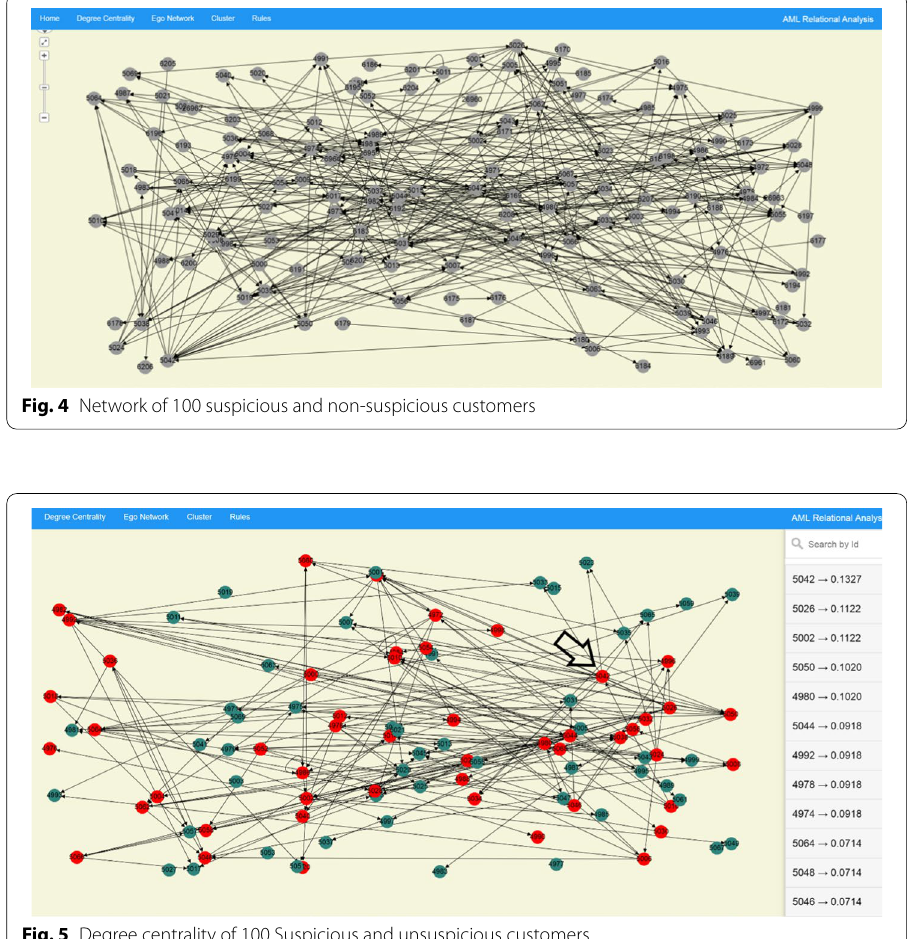
Fig. 5 Degree centrality of 100 Suspicious and unsuspicious